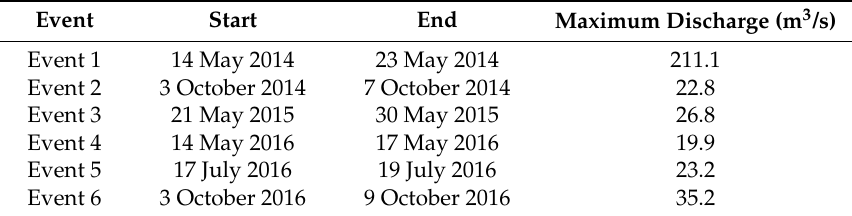
Table 1. Characteristics of the investigated flash flood events.